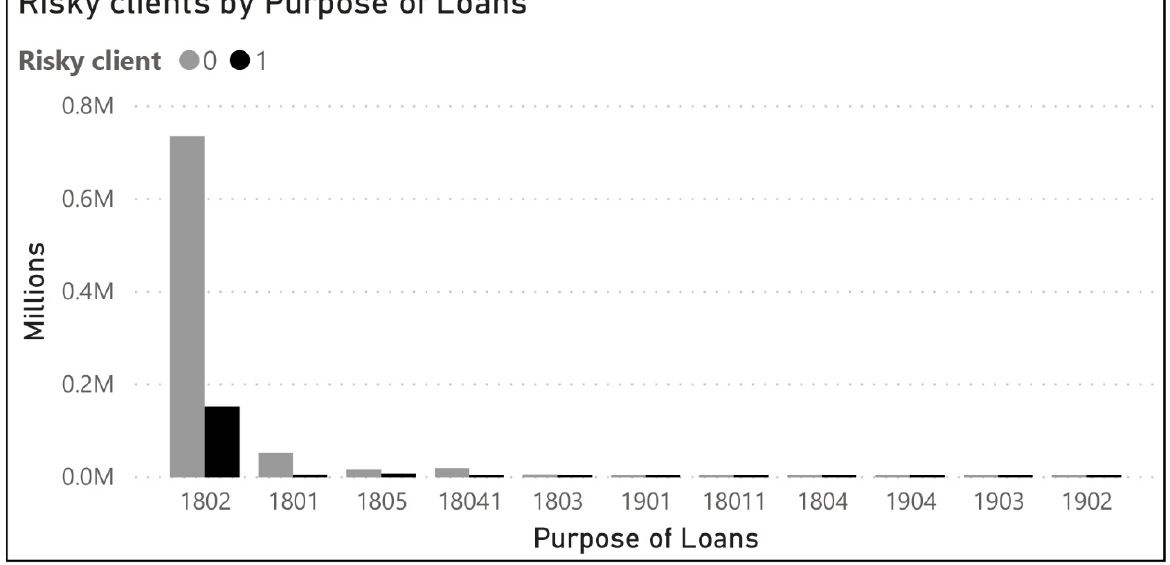
Figure 5. Risky borrowers by purpose of active loans. The figure shows the distribution of borrowers depending on the purpose of loan. Description about codes of purpose is presented in (INSTRUCTIONS for Implementation of the Decision on the Contents and the Manner of Functioning of the Credit Registry n.d., p. 16).